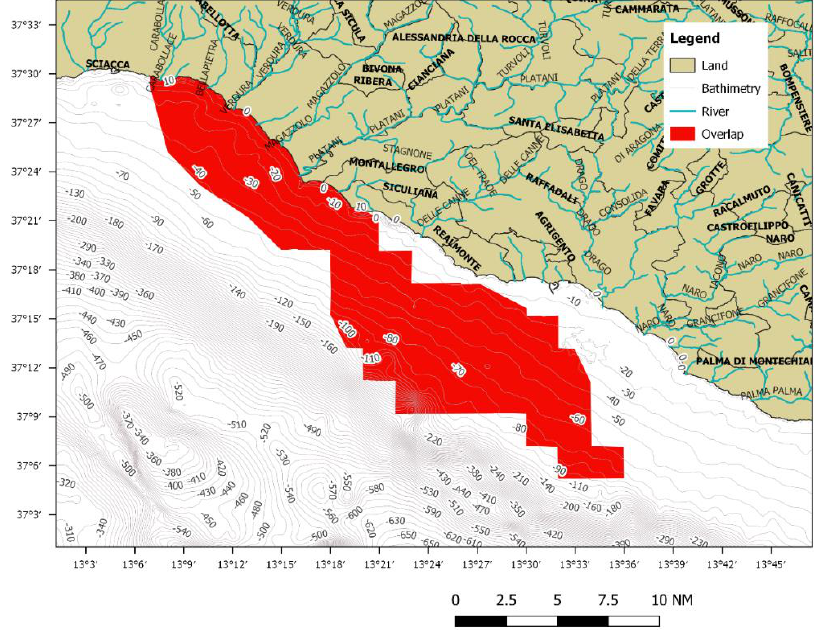
Figure 12. Map of the biodiversity hotspot found by overlapping the hotspots (areas with high suitability, red in Figure 6) for each species (bottlenose dolphins, shearwaters, and European storm petrels).